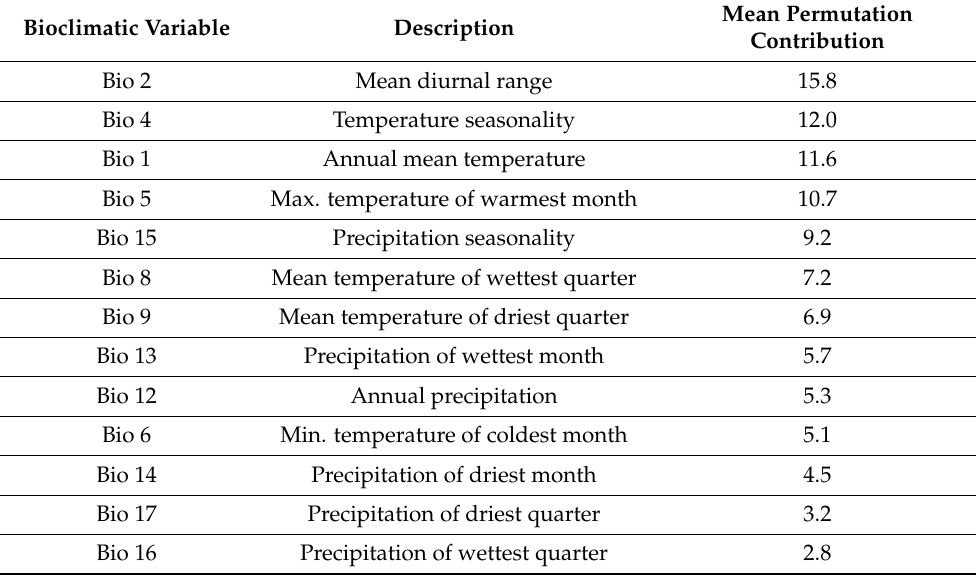
Table 1. Description of predictor variables included in our SDM modelling framework and the mean permutation contribution of each variable averaged across all of our top